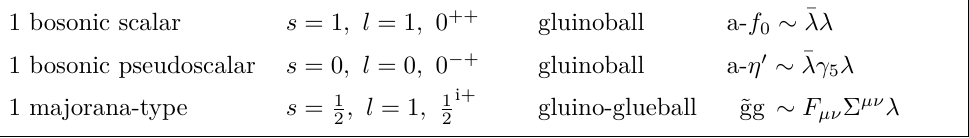
Table 1 . Veneziano-Yankielowicz